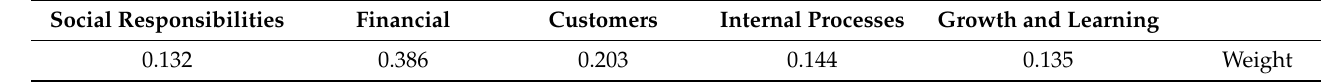
Table 4. The weight of the balanced scorecard domains.